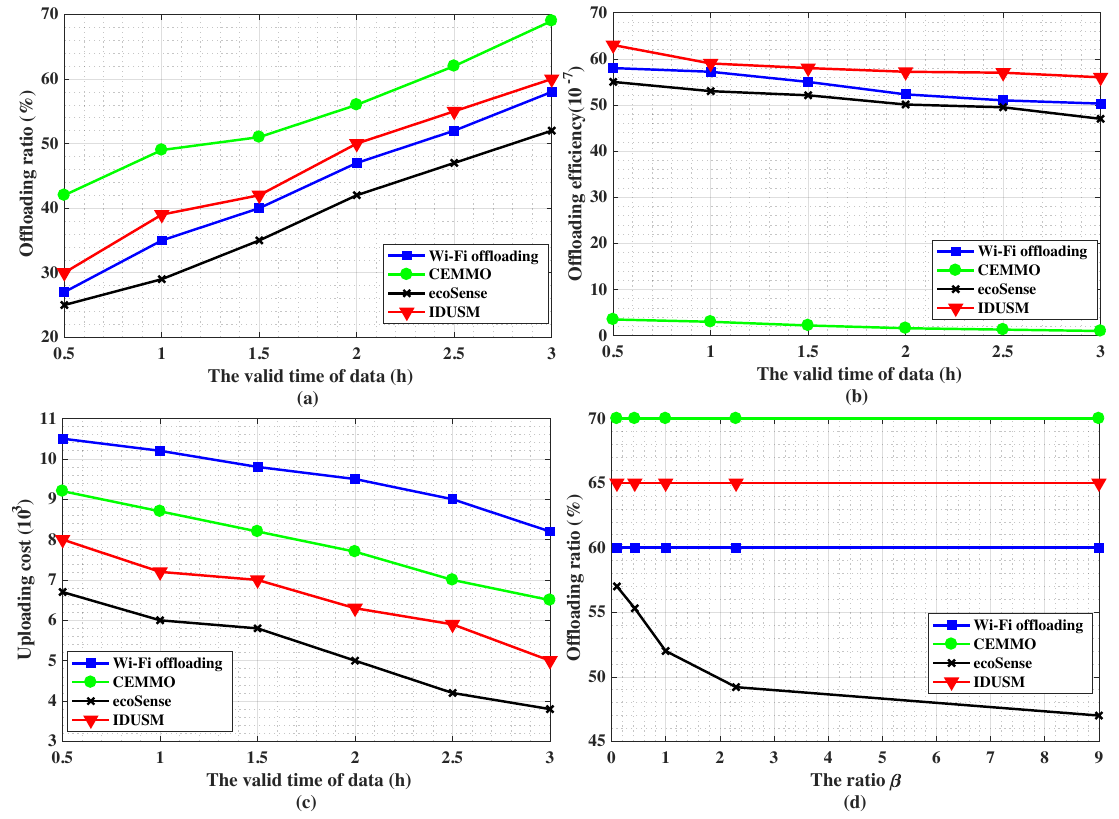
Figure 8. ( a ) The impact of the valid time of data on offloading ratio. ( b ) The impact of the valid time of data on offloading efficiency. ( c ) The impact of the valid time of data on uploading cost. ( d ) The impact of the ratio β on offloading ratio.